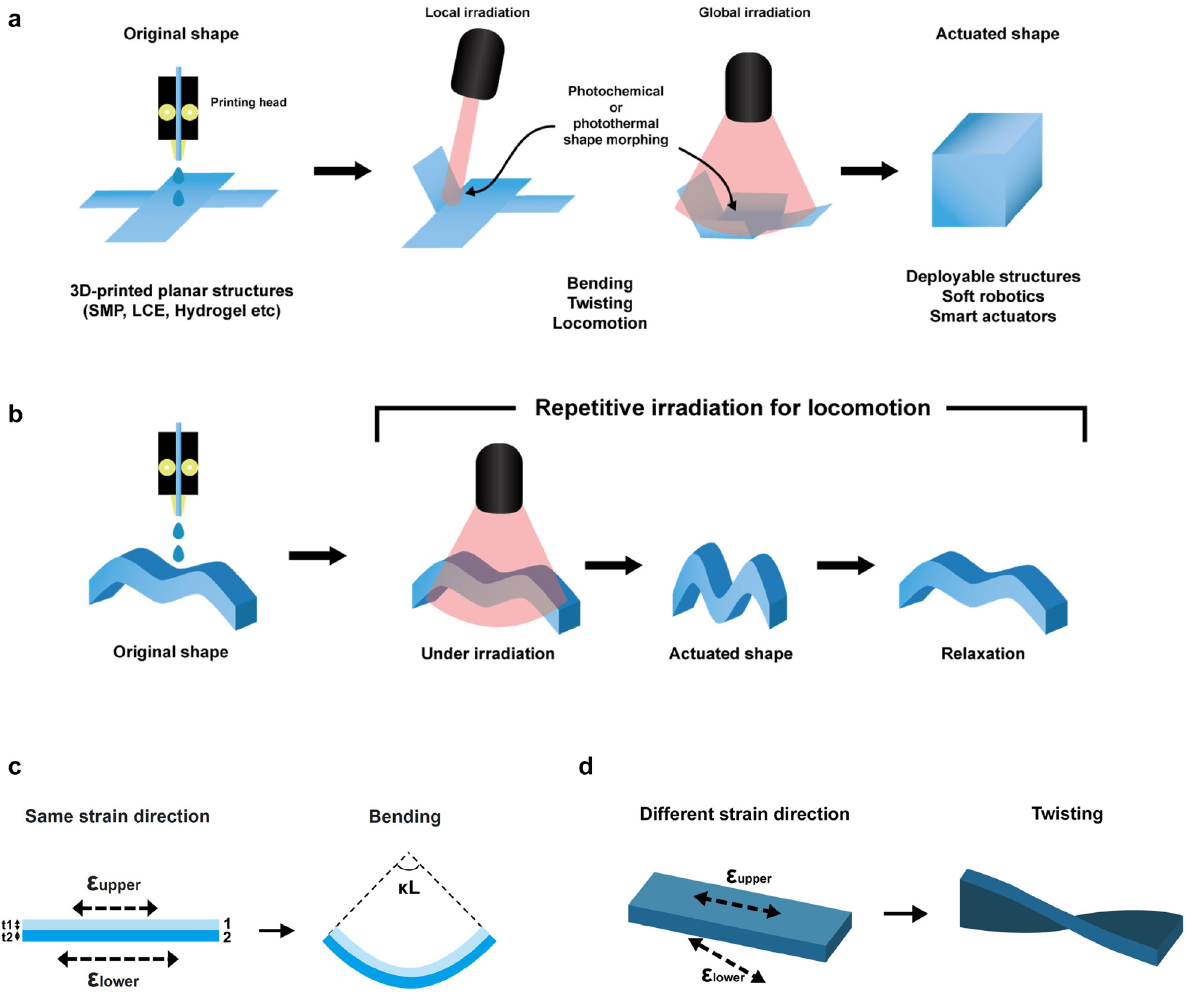
Figure 1: General concept for the light activation of 3D-printed structures. (a) 3D-printed planar structures can be transformed into 3D structures under local or global light illumination. Deployable or adaptive structures can be realized with desired structural and functional changes. (b) 3D-printed nonplanar structures can be transformed into other 3D structures under light illumination. Light-induced locomotion can be realized by repetitive light irradiation. (c) Bending of a bilayer structure. The thicknesses of the upper and lower layers are t 1 and t 2 , respectively, and the length is L. (d) Twisting of a bilayer